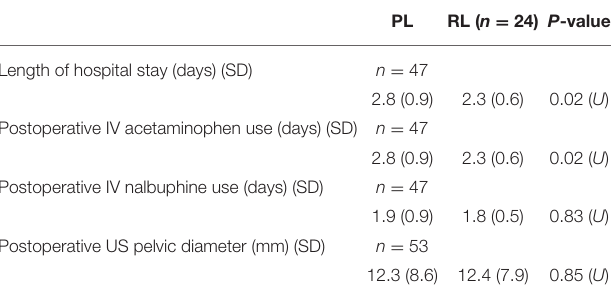
TABLE 3 | Postoperative parameters.